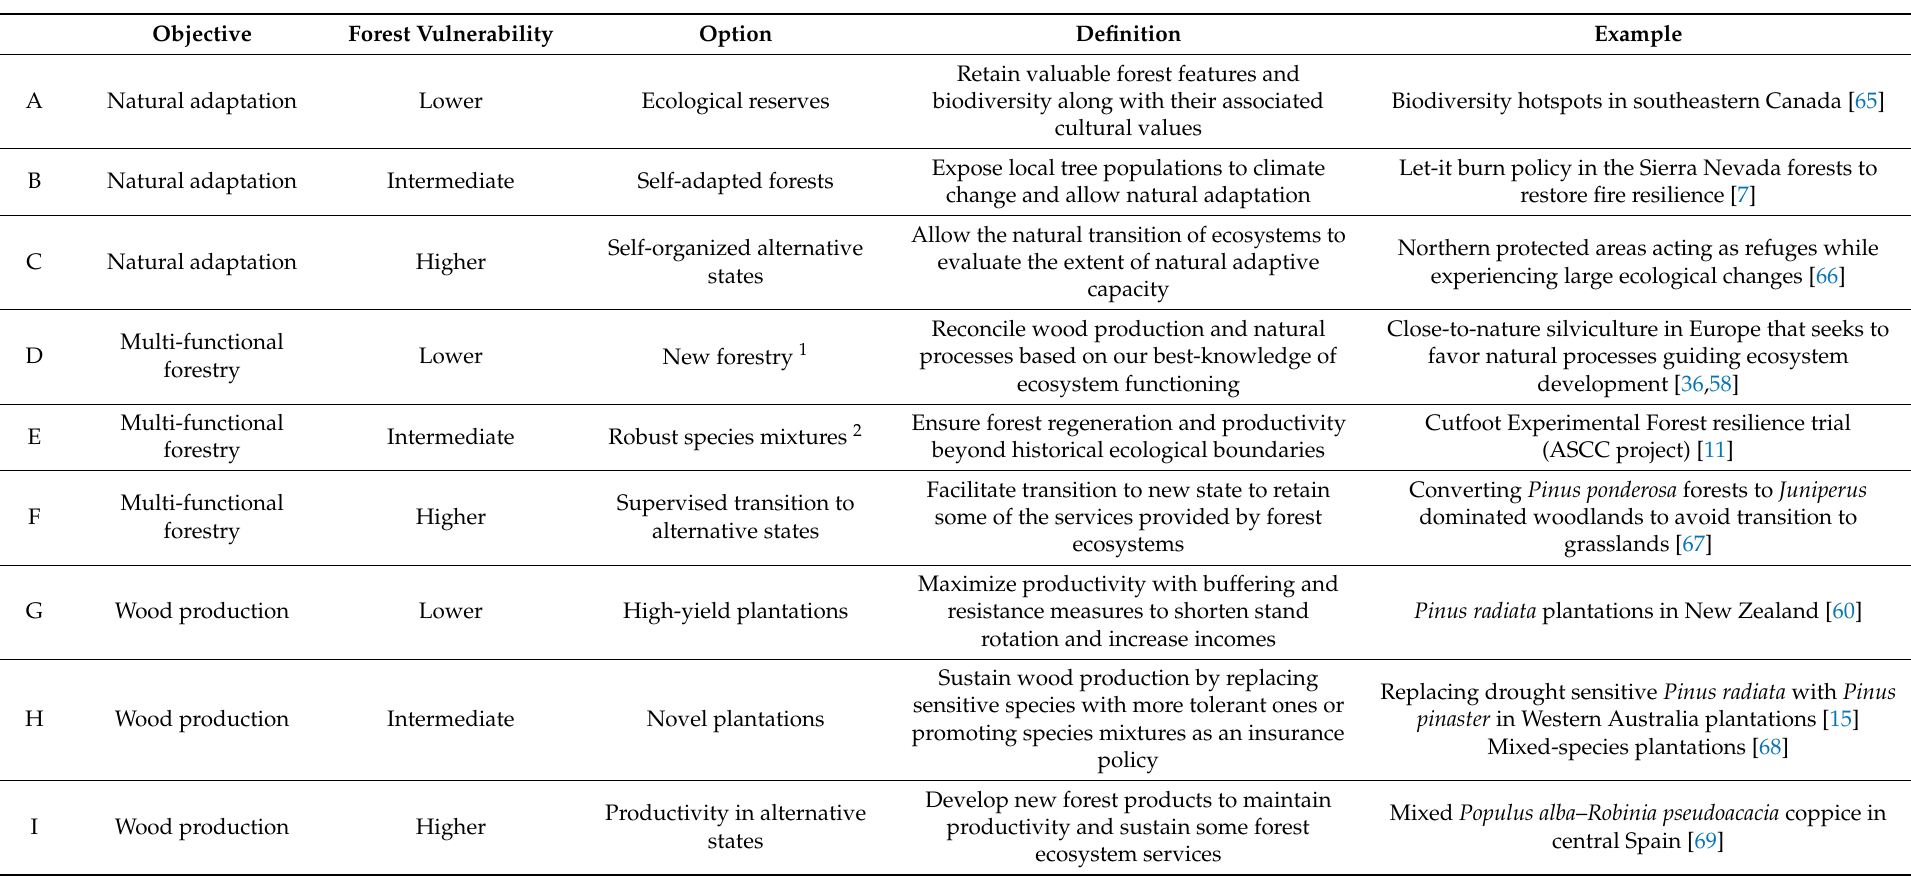
Table 1. Examples of management options for adaptation to climate change corresponding to different combinations of the three management objectives: favoring natural adaptive capacity (natural adaptation), promoting multiple functions within each stand (multi-functional forestry), and emphasizing forest productivity (wood production) with three levels of forest vulnerability: lower, intermediate, and higher. Letters in the first column refer to Figure 1. Main objective and examples for each option are also provided. 1 New forestry sensu [22], i.e., practices that trade single-purpose timber production for a more holistic ecosystem orientation considering stand diversity and biological legacies. 2 Species mixtures that are able to provide services under different environmental conditions. ASCC: Adaptive Silviculture for Climate